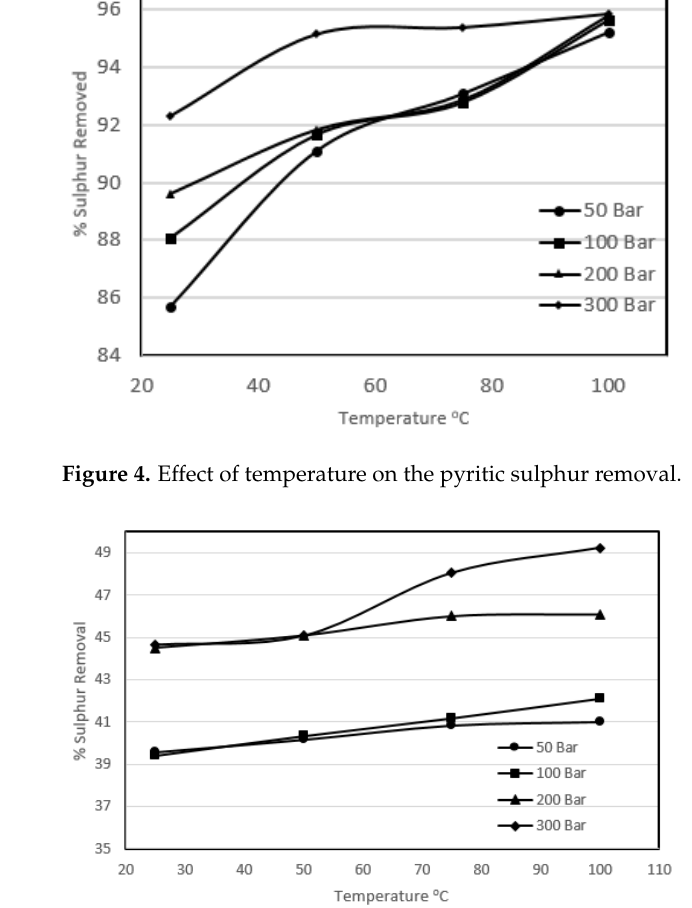
Figure 5. Effect of temperature on the organic sulphur removal.